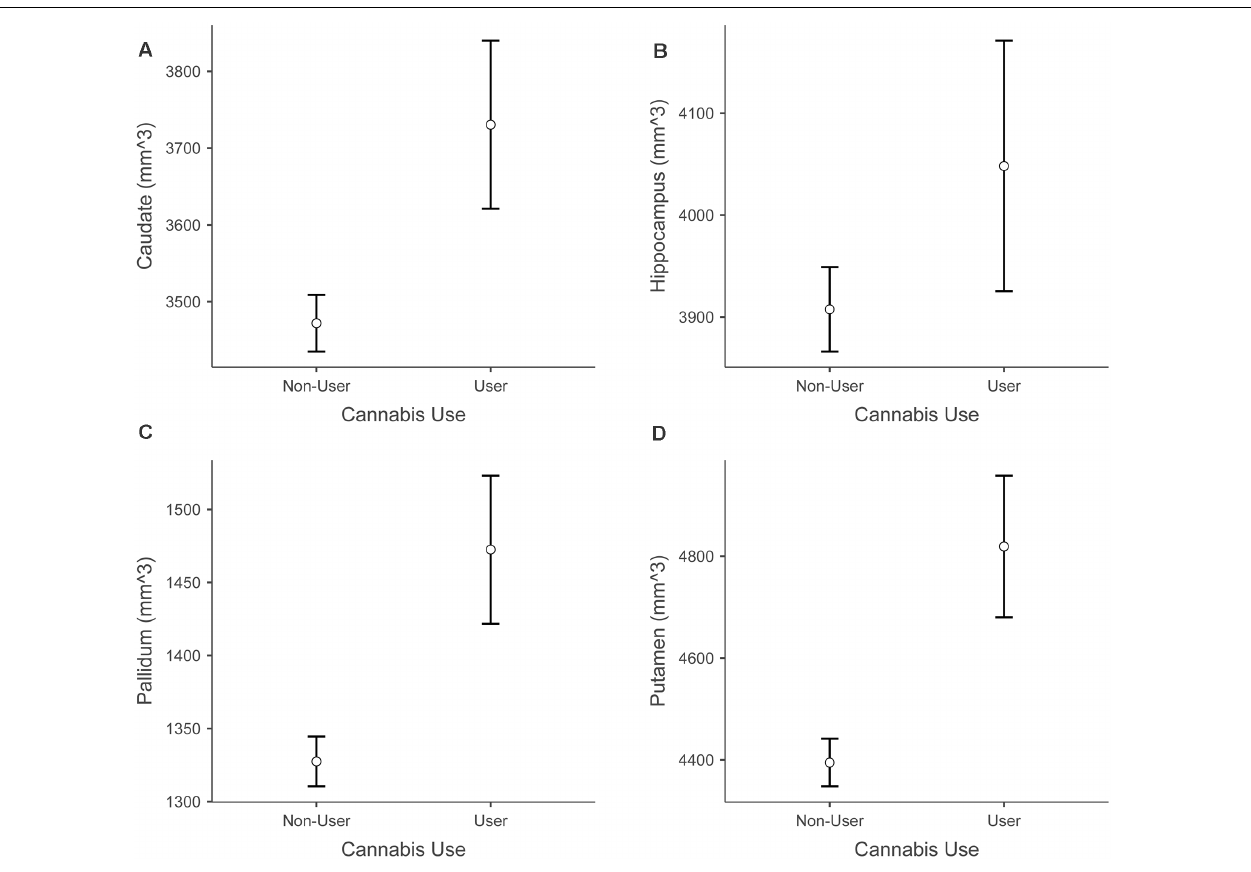
FIGURE 7 | Differences between cannabis users and non-users across subcortical volumes. Panel (A) shows increased caudate volume in cannabis users vs. non-users. Panel (B) shows increased hippocampus volume in cannabis users vs. non-users. Panel (C) shows increased pallidum volume in cannabis users vs. non-users. Panel (D) shows increased putamen volume in cannabis users vs. non-users. Error bars depict standard